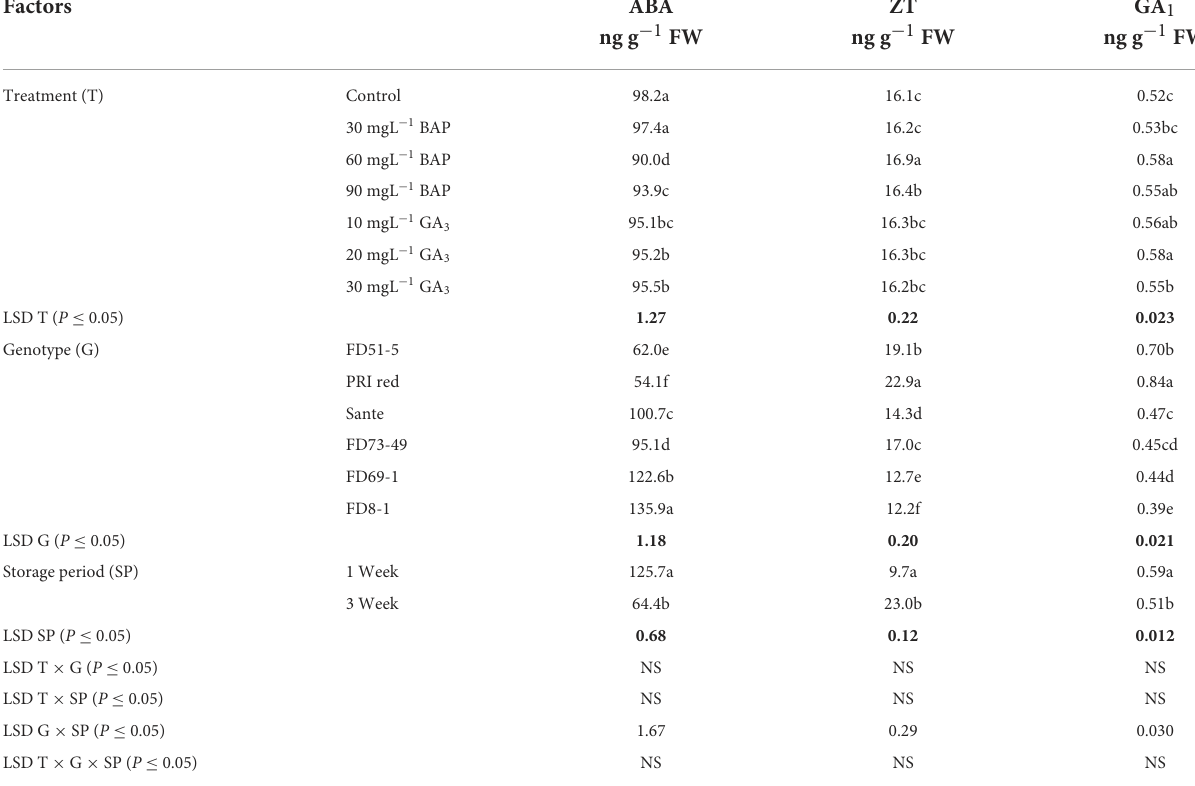
TABLE 1B Periodic changes in the contents of ABA, ZT, and GA 1 in experimental tubers of six potato genotypes dipped in PGRs during 2018.